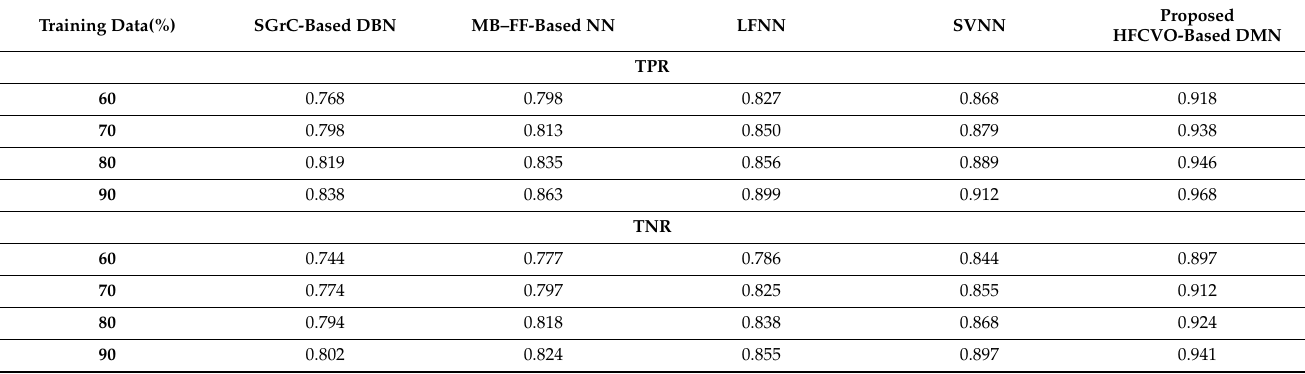
Table 7. Comparative analysis using Real-time dataset for TPR, TNR, FNR, precision, and testing